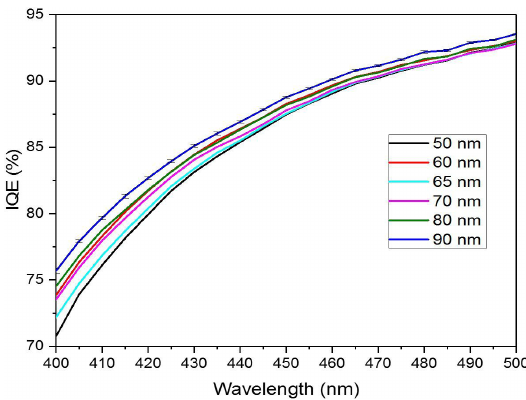
Figure 7. IQE in the range of 400 nm to 500 nm for solar cells with different thickness of TiO layer. Error bar over the line corresponding 2 to 90 nm thick films are